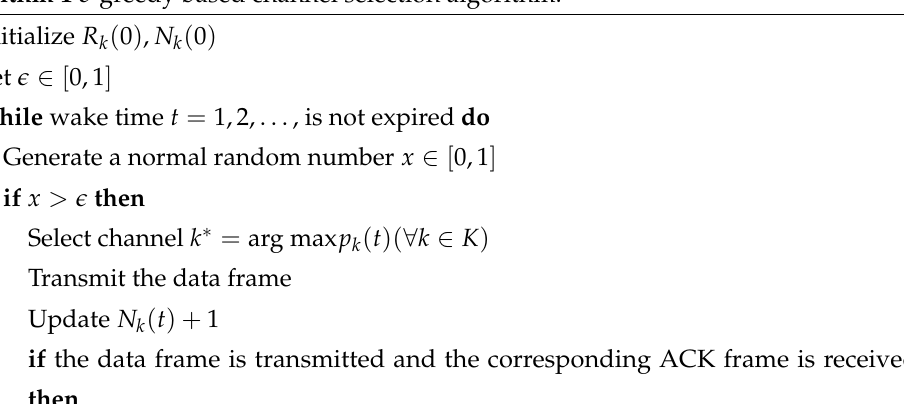
Algorithm 1 (cid:101) -greedy based channel selection